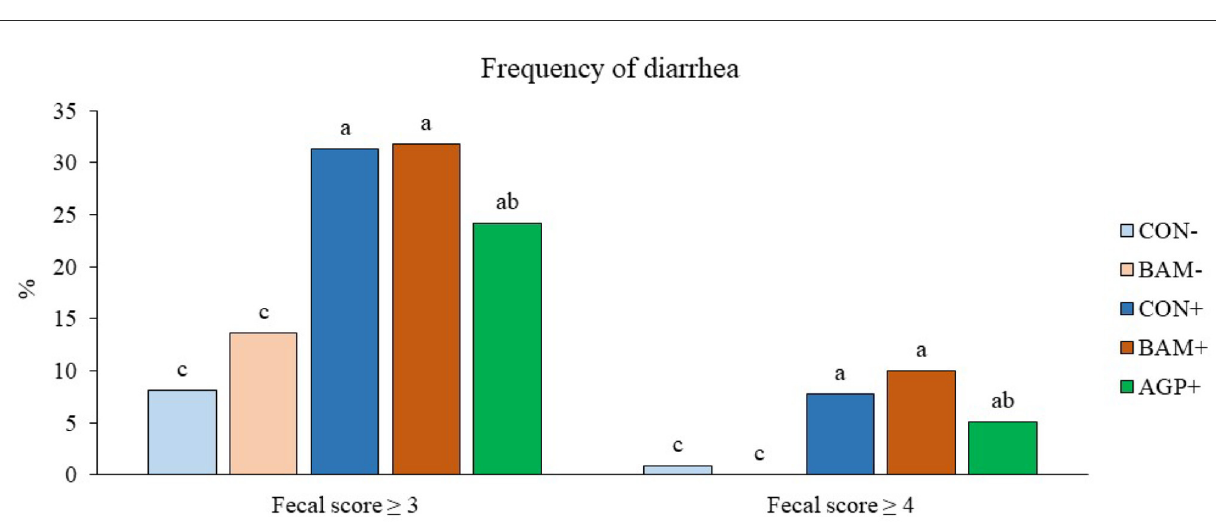
FIGURE2 Frequency of diarrhea in weaned pigs fed diets supplemented with Bacillus amyloliquefaciens (BAM) or antibiotics (AGP). The frequency of diarrhea was calculated as the percentage of pig days with a fecal score ≥ 3 or ≥ 4 in the total number of pig days. Each least squares mean represents 9–10 observations. a − c Means without a common superscript are different ( P <